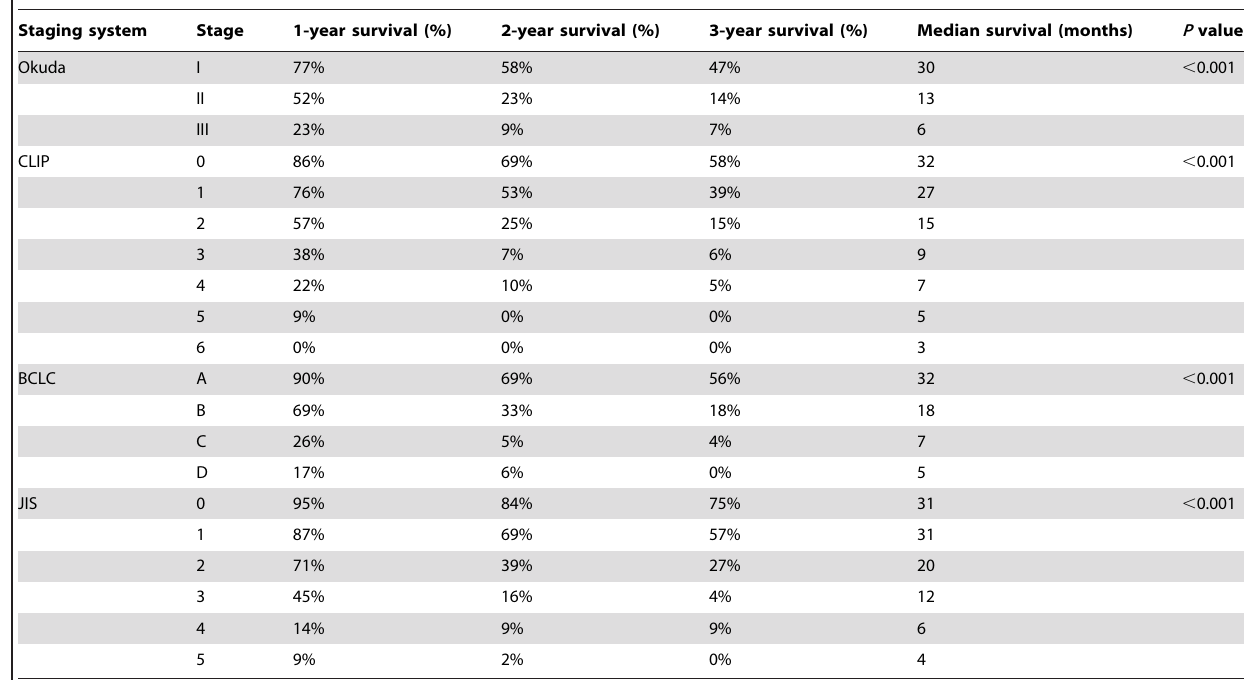
Table 5. Patient survival according to different staging systems.